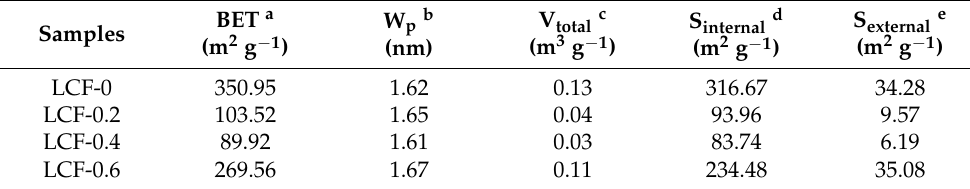
Table 3. Textural properties of the LCFs with varying Ni(acac) 2